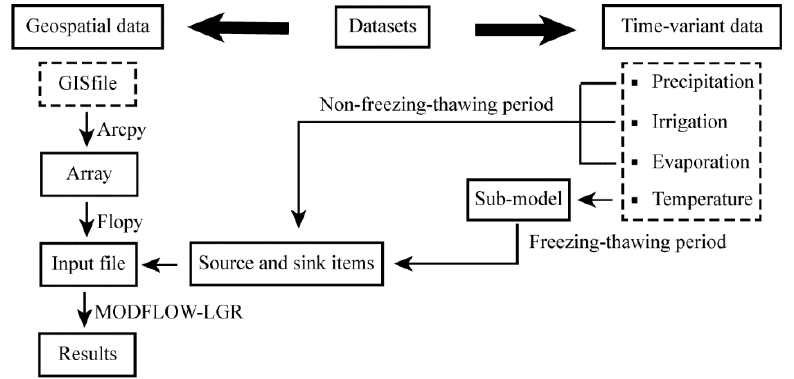
Figure 4. Flowchart of coupled model.